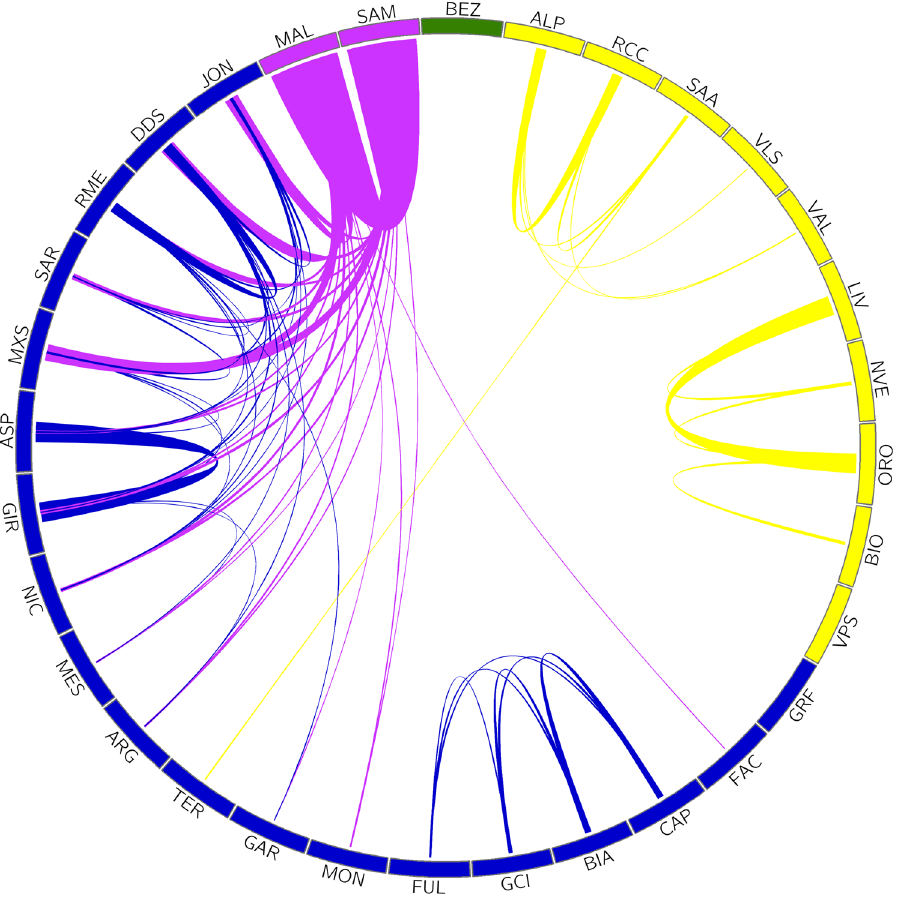
Figure 3. Proportion of the median haplotype shared among the Italian goat populations. The colours reflect the ADMIXTURE components at K = 3, which overlap with the administrative and temporal history of the Italian Peninsula until 1860. The outgroup is highlighted in green (extended name reported in Table 1). The figure was generated using Circos v0.69-8 Software 22